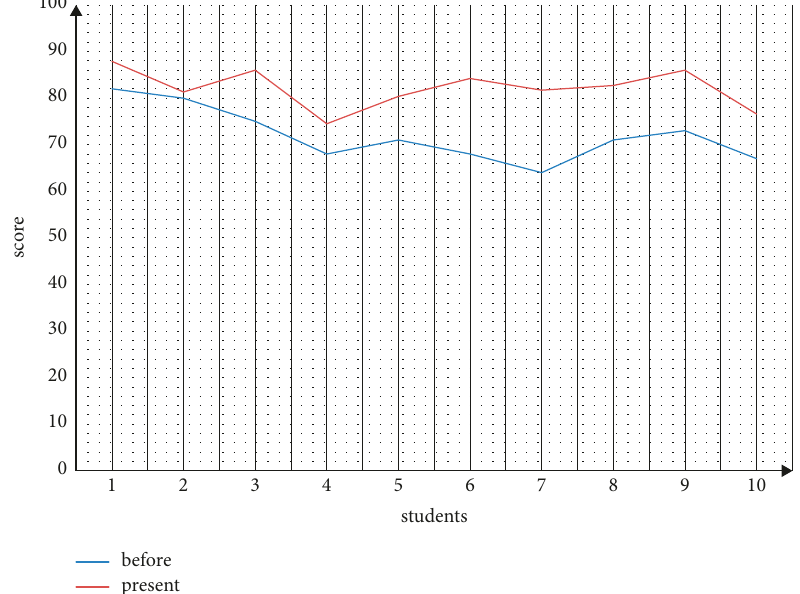
Figure 9: Comparison of the results of ten students and the final results of the previous